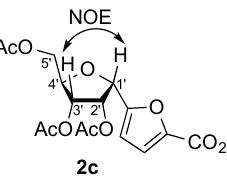
Figure 2. NOESY correlation in 2c .